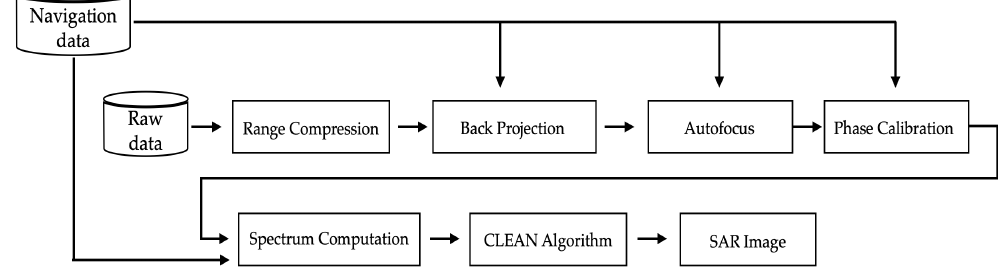
Figure 3. Grating lobes suppression workflow block